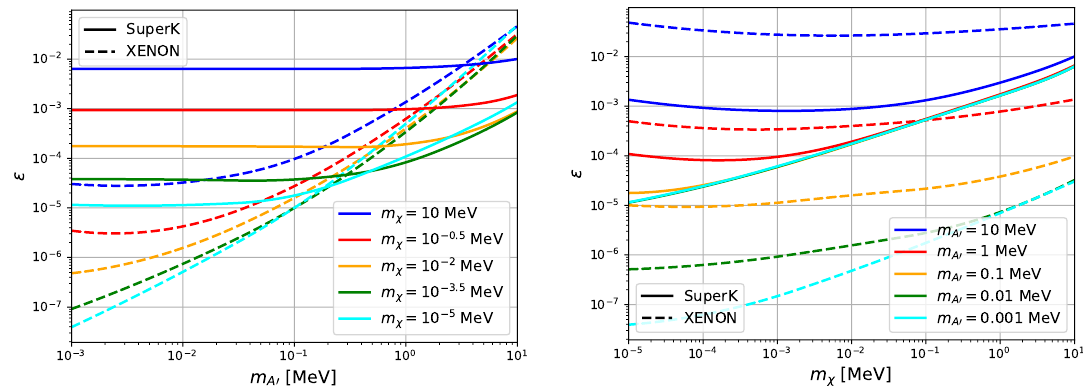
Figure 3 . Left panel: exclusion limits of XENON1T (dashed lines) and Super-K (solid lines) in the m A 0 − (cid:15) plane. The values of m χ are indicated by the line colors. Right panel: exclusion limits of XENON1T (dashed lines) and Super-K (solid lines) in the m χ − (cid:15) plane. The values of m A 0 are indicated by the line colors. In both cases, the DM coupling g 0 = 1